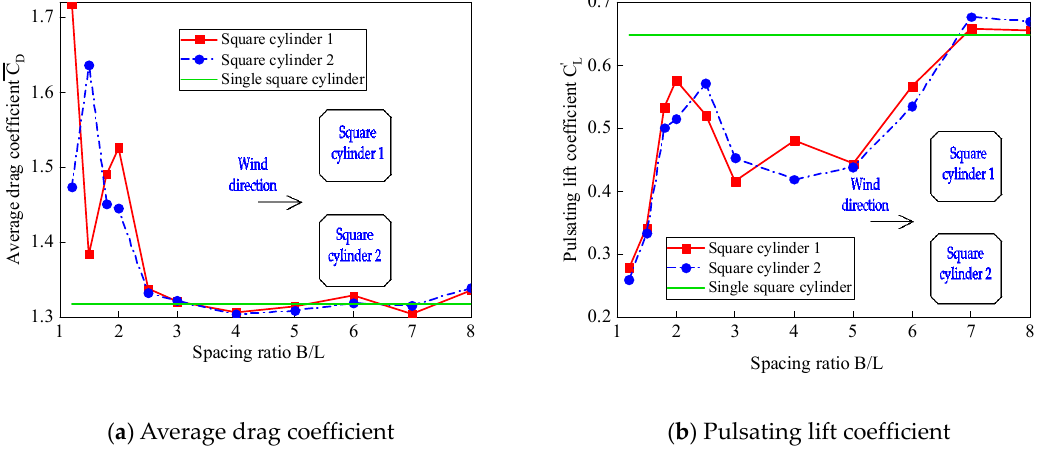
Figure 7. Variation curve of aerodynamic coefficient of juxtaposed square cylinders with spacing